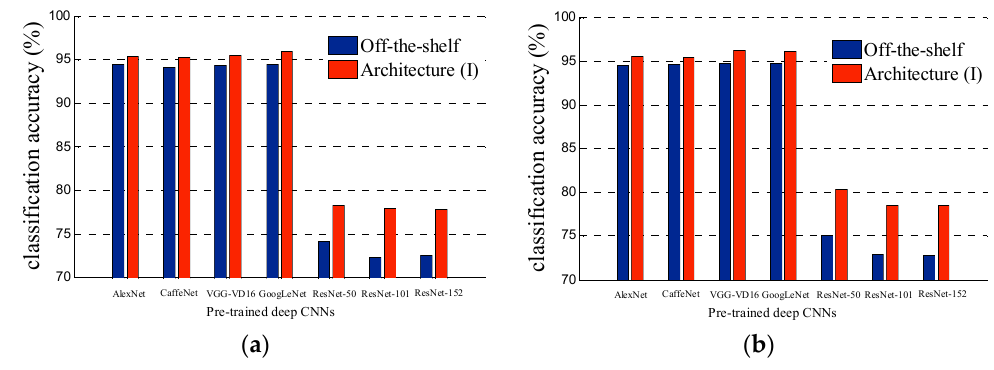
Figure 11. Accuracy of remote scene classification on: ( a ) UC Merced dataset; and ( b ) WHU-RS dataset.